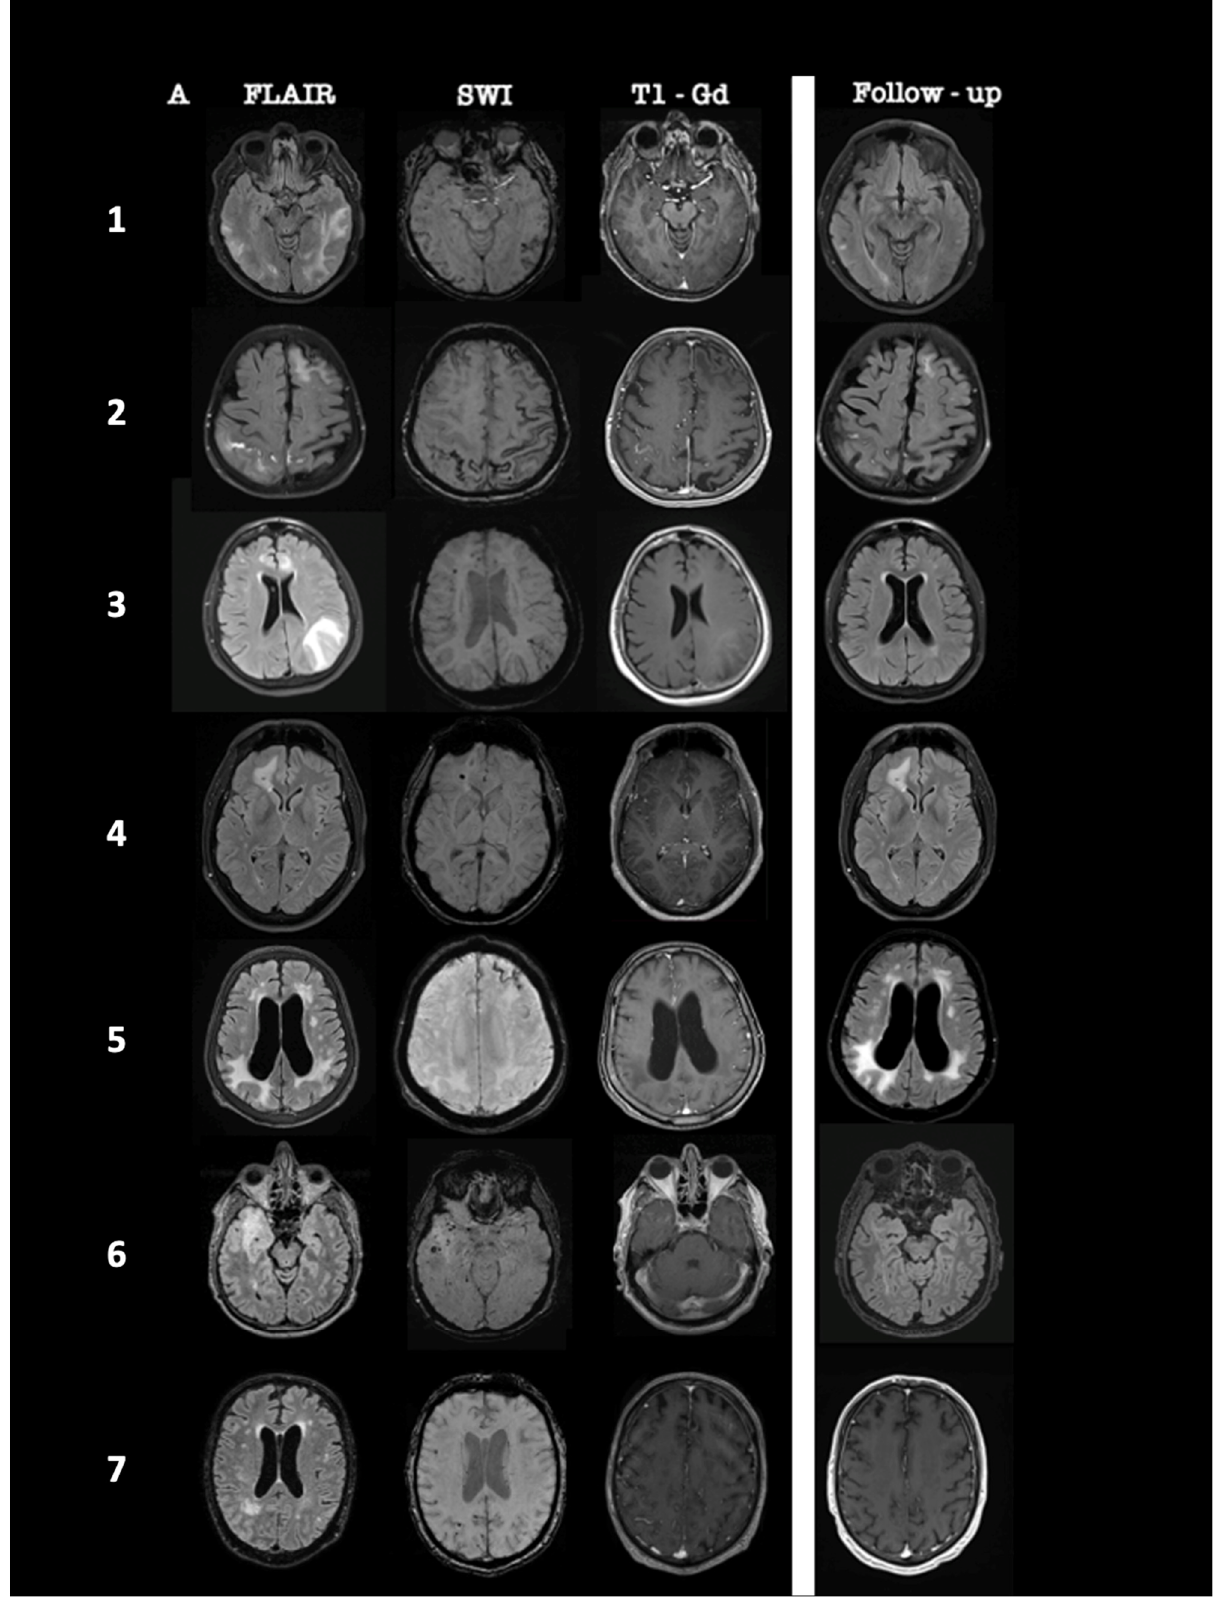
Figure 1. Summary of brain MRI characteristics of 7 patients at diagnosis and one month after treatment initiation. MRI findings of patients #1 to #7 are ordered from the top to the bottom. At diagnosis, axial fluid-attenuated inversion recovery (FLAIR) sequences showed supratentorial white matter lesions, multifocal in patients #1, #2, #3, and #5 and unifocal in patients #4, #6, and #7.